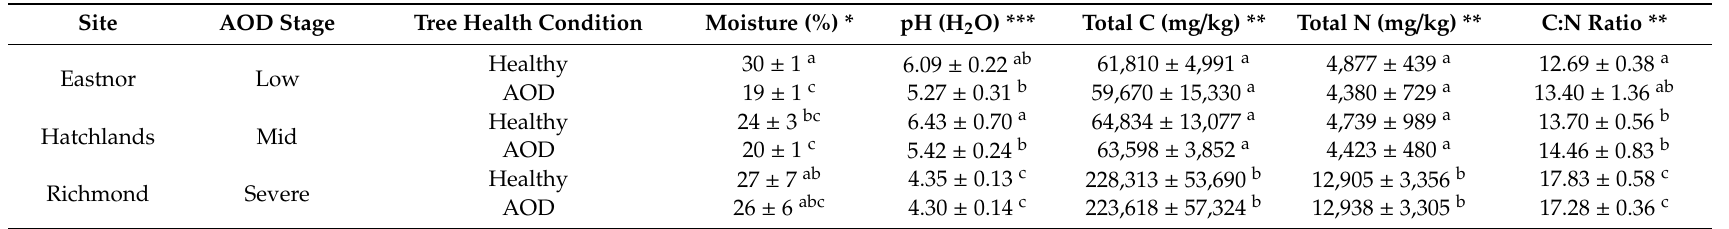
Table 1. Physicochemical properties of the oak rhizosphere soils across the sites and tree health